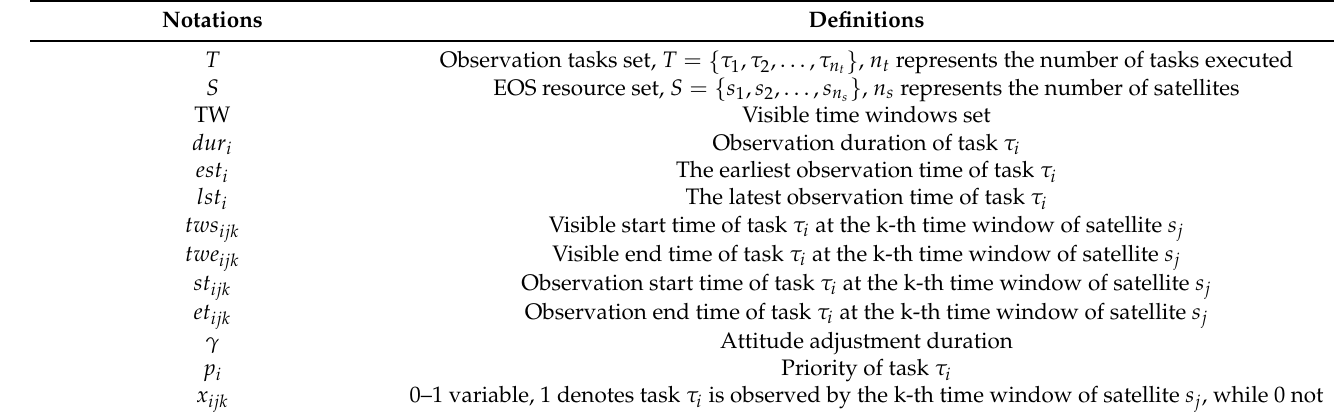
Table 1. Definitions of the notations in